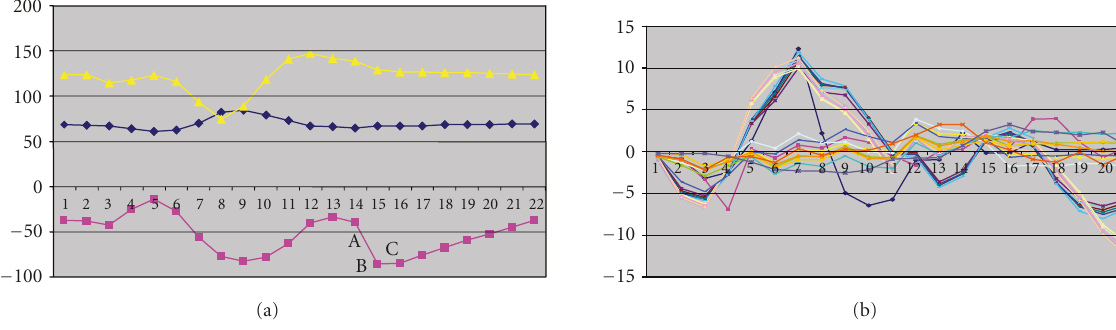
Figure 9: Movement along the x ( (cid:2) ), y ( (cid:3) ), and z ( (cid:4) ) axes of the centre of a single bone (a) and all extreme bones